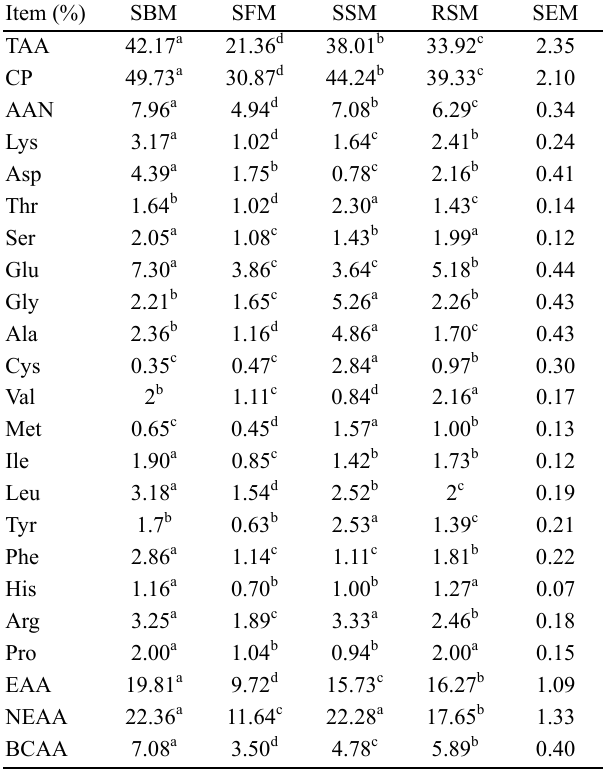
Table 3. Chemical composition of the SBM, SFM, SSM and RSM (DM basis)